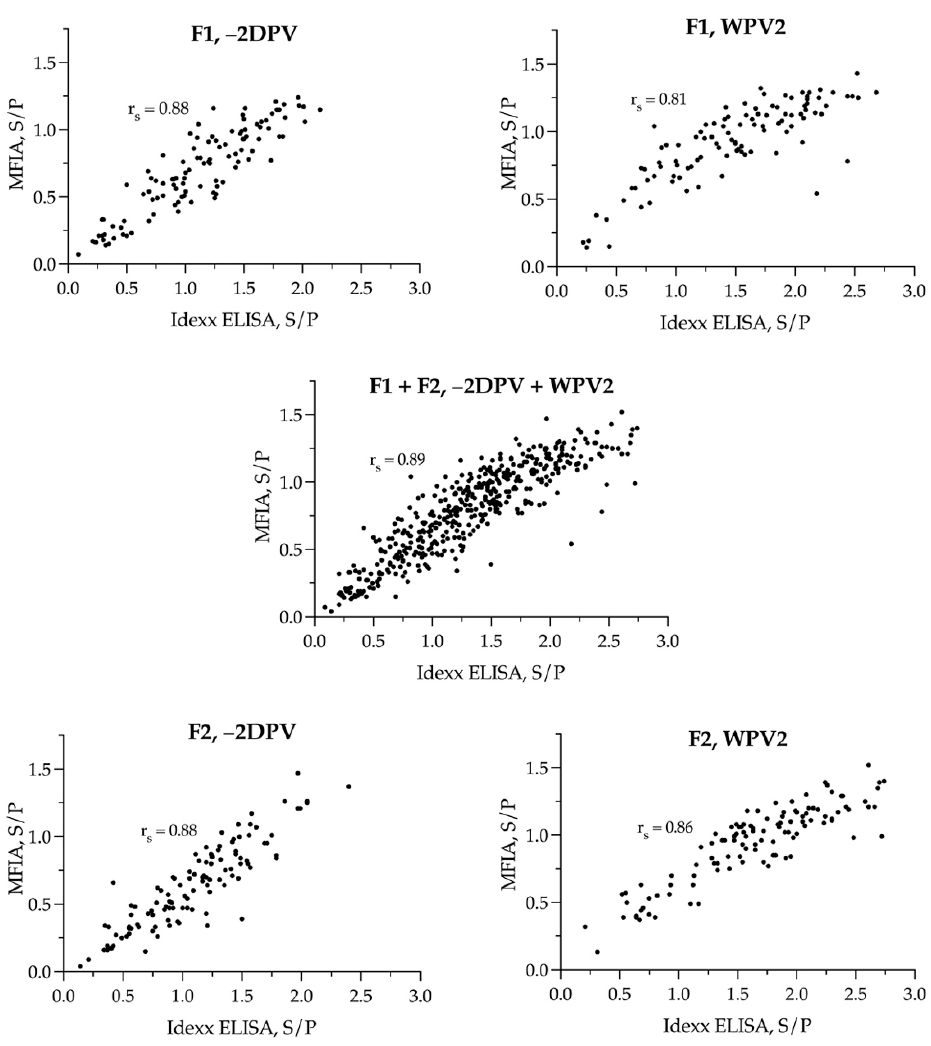
Figure 3. Scatterplots with PRRSV ‐ 1 S/P values as results of both Idexx ELISA ( x ‐ axis) and MFIA ( y ‐ axis) before ( − 2DPV) and after PRRSV ‐ 1 MLV mass vaccination (WPV2) on Farm 1 (F1) and Farm 2 (F2), and in total for both herds (Both) in the study. Correlation coefficients for the monotonic relationship are given as r s in each figure. Table 4. Agreements between Idexx ELISA and MFIA. Cohen’s kappa agreement coefficient ( κ ) between PRRSV ‐ 1 S/P antibody results in Idexx ELISA and ratio in MFIA before ( − 2DPV) and after PRRSV ‐ 1 MLV mass vaccination (WPV2) and in total for both serological assays in the study of two herds. Furthermore, standard error ( SE ), 95% confidence intervals